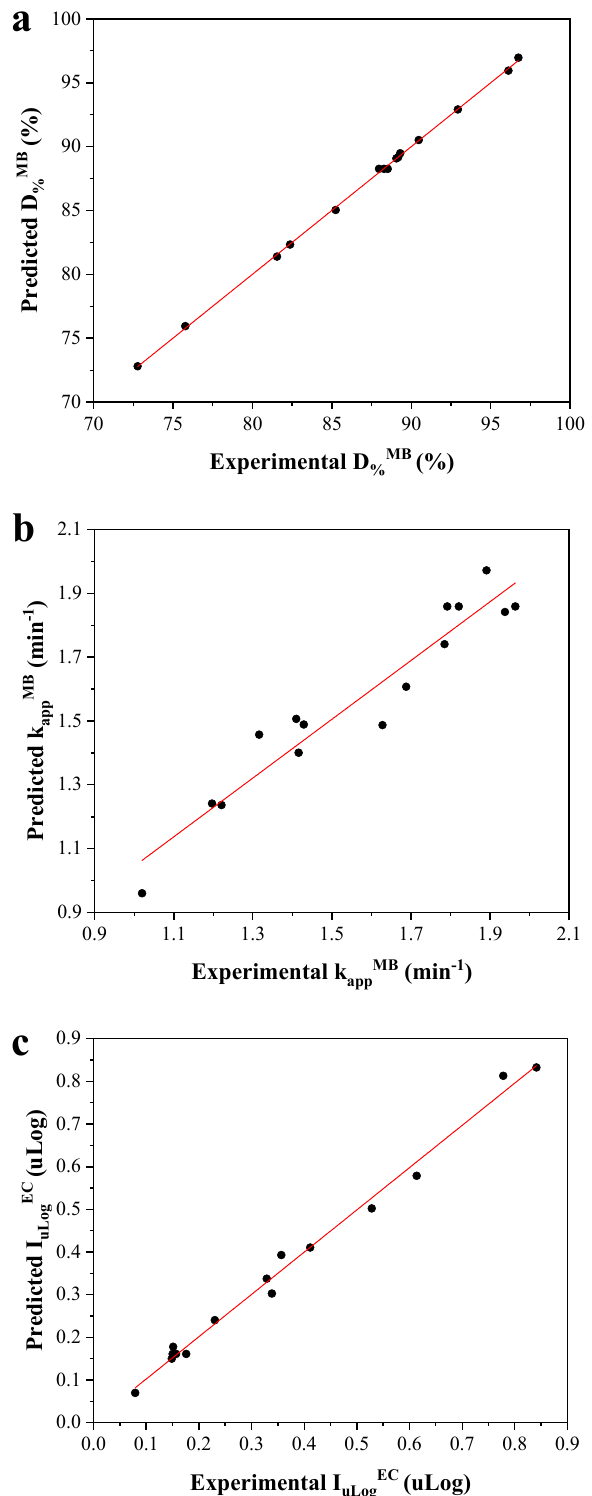
Figure 1. Correlations between the experimental and predicted values of ( a ) D % MB values, ( b ) k app MB values and ( c ) I uLog EC values.